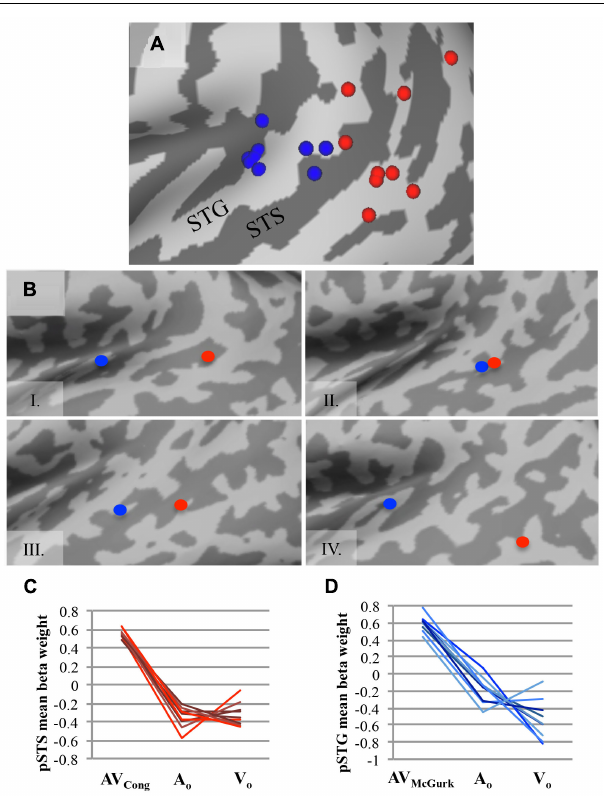
FIGURE 2 |AV speech areas for congruent and McGurk speech in the left posterior superior temporal cortex: consistency across single subjects. (A) The center of gravity for clusters with significantly greater fMRI signal for AV trials than for both types of unimodal trials (AV > A O ∩ AV > V O ) are plotted for each participant on an inflated template cortical surface (single-voxel threshold t > 2.2461, p < 0.025). Although the functional location varies, nine out of ten participants exhibited a significant AV effect for AV Cong speech in the left pSTS region (red), and all participants but one exhibited significant AV effects for AV McGurk speech in the left pSTG region (blue). (B) Four representative single-subject cortical surface maps are displayed with each participant’s foci projected on the inflated surface. Foci represent the center of gravity for clusters with significantly greater fMRI signal for AV speech compared to unimodal speech (AV > A O ∩ AV > V O ). Red dots represent AV Cong speech, and blue dots represent AV McGurk speech. In most participants, the congruent AV speech clusters were located more posteriorly compared to the McGurk speech clusters. For (A) and (B) , only the left posterior superior temporal cortex (also including lateral fissure) is displayed. (C,D) For each participant, mean fMRI signal from each cluster, estimated by mean beta weight and identified from single-subject activation maps, is depicted for AV and unimodal trials in the left pSTS region (C) and the left pSTG region (D) ; each line represents a single participant. Abbreviations as in Figure 1